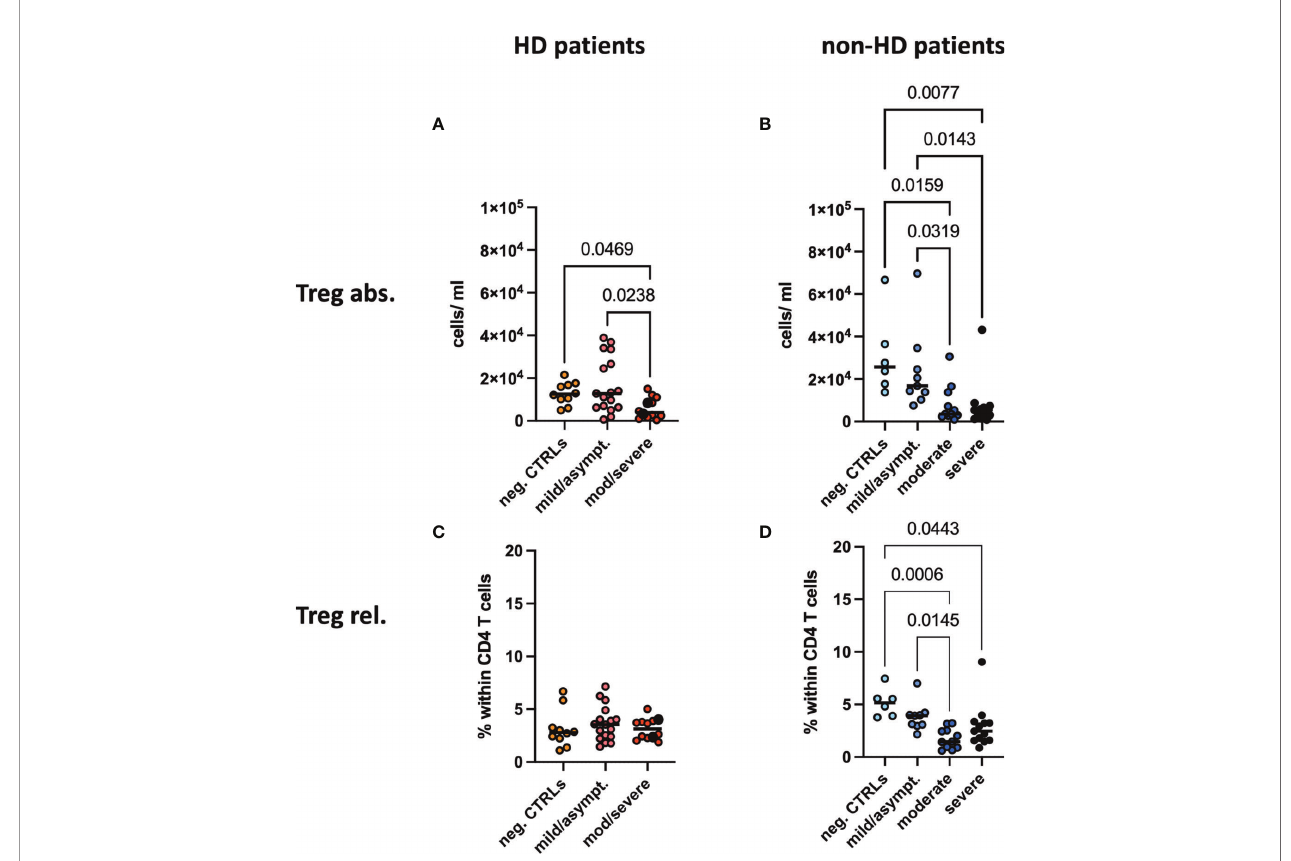
FIGURE 3 | Absolute numbers and frequencies of Tregs in peripheral blood. (A, B) Absolute numbers and (C, D) frequencies of regulatory T cells (Tregs) were evaluated in the peripheral blood of (A, C) HD- and (B, D) non-HD patients without SARS-CoV-2 infection (orange circles, HD: n = 10; light blue circles, non-HD: 6), with mild/asymptomatic (light red circles, HD: n = 18; mid blue circles, non-HD: n = 9), moderate (red circles, HD: n = 11; blue circles, non-HD: n = 11) and severe COVID-19 disease (black circles, HD: n = 2; dark blue circles, non-HD: n = 13). Severe and moderate COVID-19 HD patients were analyzed as one group. Data are shown as individual values as well as